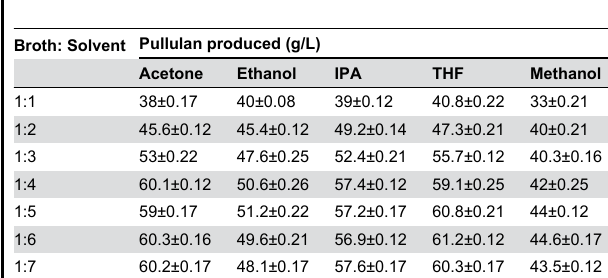
Table 3. Screening of solvents for pullulan precipitation.